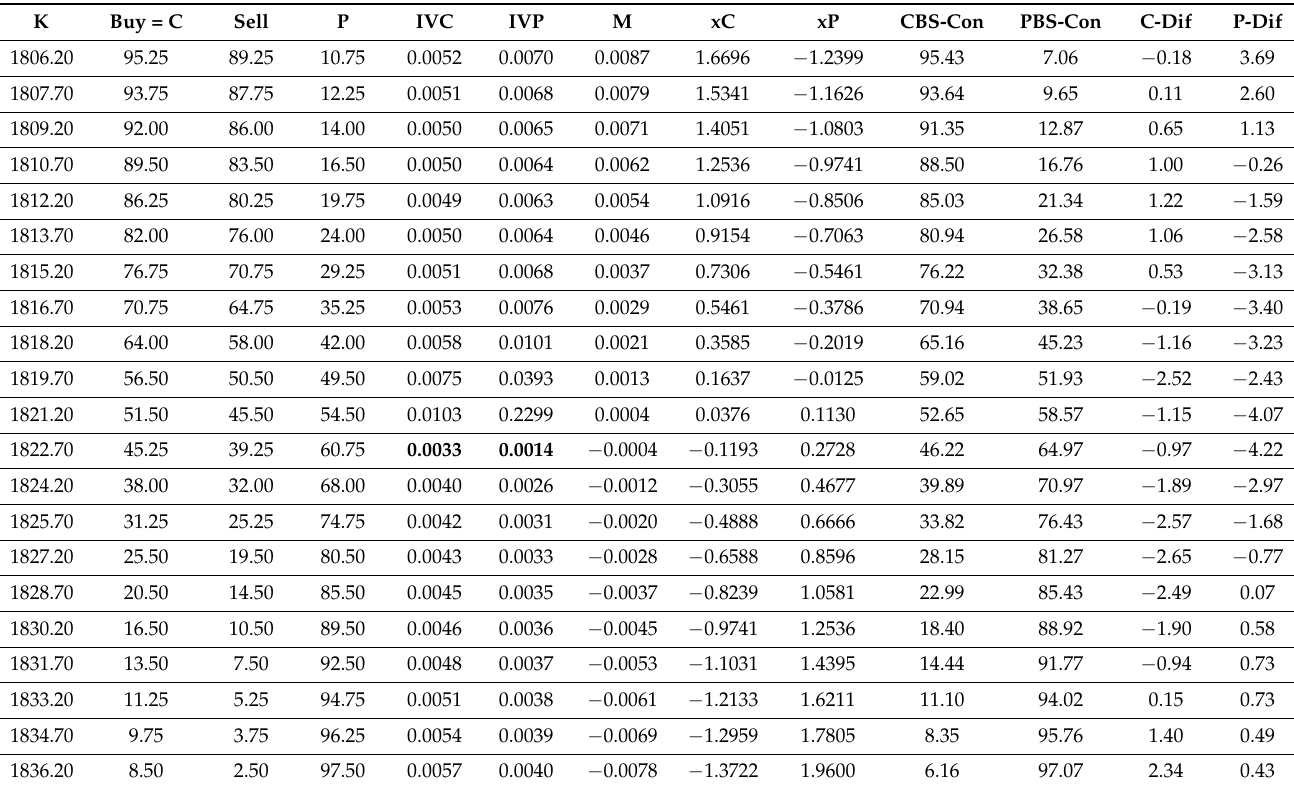
Table 1. BS formulas applied to Nadex one day Gold binary data of 8 February 2022 at gold price S 0 =